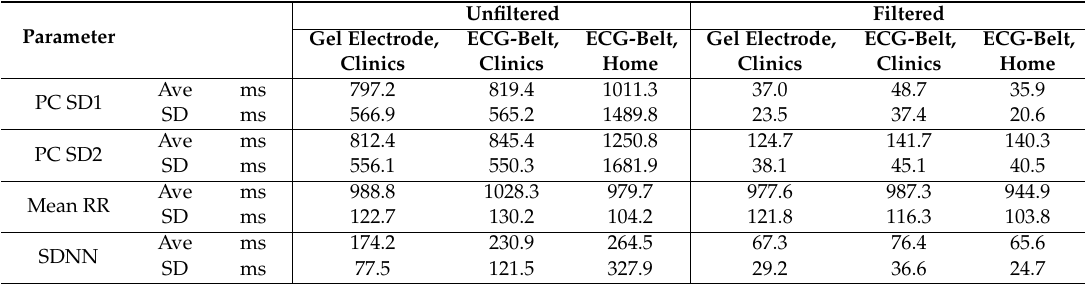
Figure 2. Exemplary Poincar é plots: ( A ) artefacts percentage of 0.2%; ( B ) artefacts percentage of 6.2% (artefacts caused by pathophysiological issues); ( C ) artefacts percentage of 11.3% (artefacts caused by noise). Table 4. Absolute values for Poincar é SD1 (PC SD1) and SD2 (PC SD2), as well as the overnight mean RR-interval (Mean RR) and the total overnight variability of RR-intervals (SDNN) for the data from a clinical (Fontana et al. [9]) and home setting. Data are presented with (filtered) and without (unfiltered) application of the RR-interval